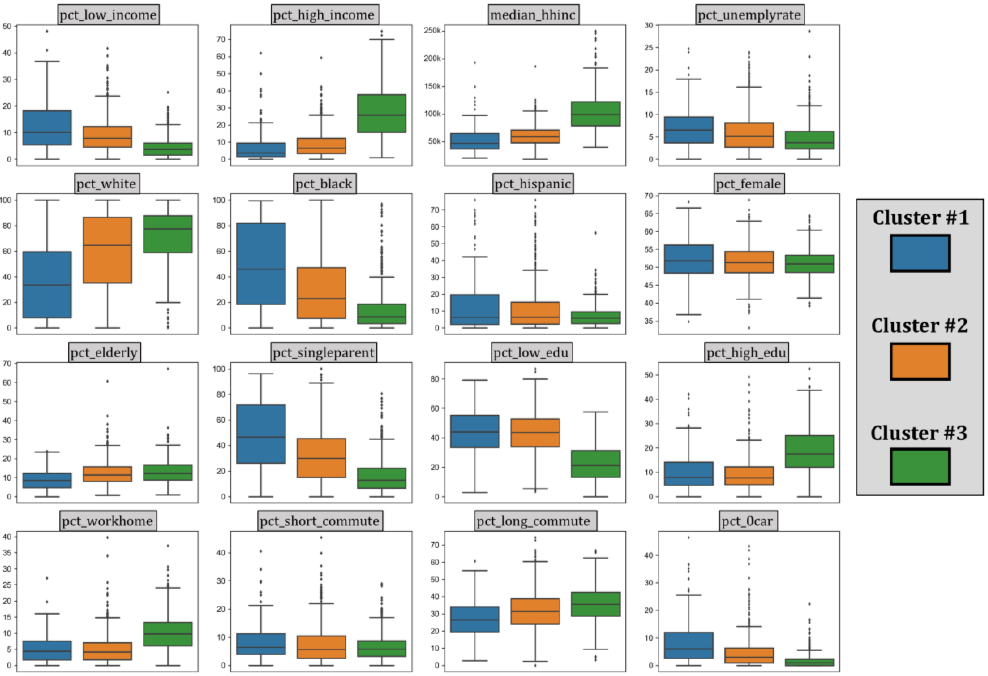
Figure 6. Selected demographic/socioeconomic variables in three identified clusters. The descriptions of these variables can be found in Table